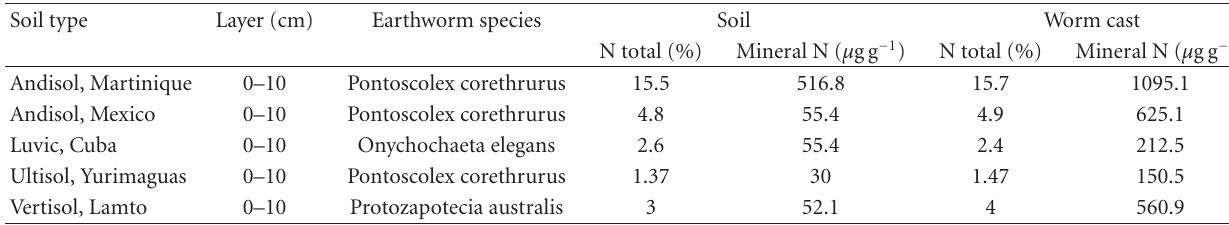
Table 6: Total and mineral nitrogen content in soil and fresh casts from earthworms incubated in di ff erent soil types (Barois et al., 1992 [53]).